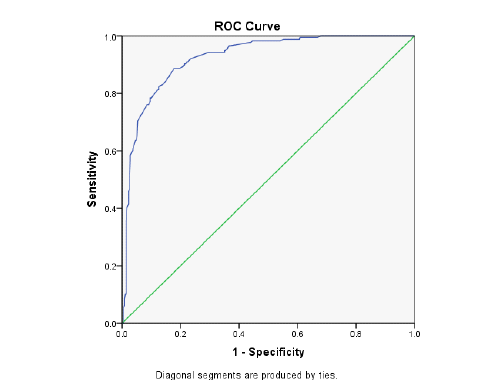
Fig 1b - ROC curve of MUAC in predicting obese